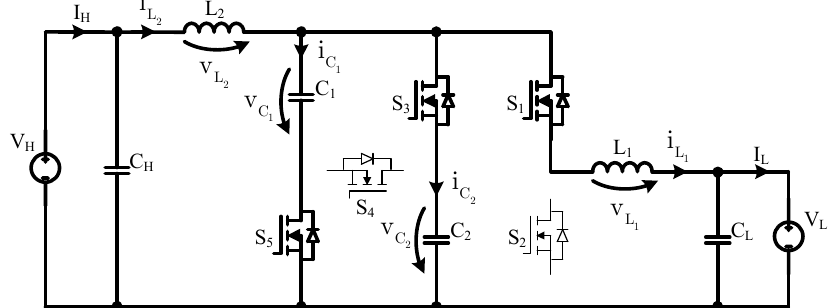
Figure 3. BHSC equivalent schematic during t on , in step-down operating mode.